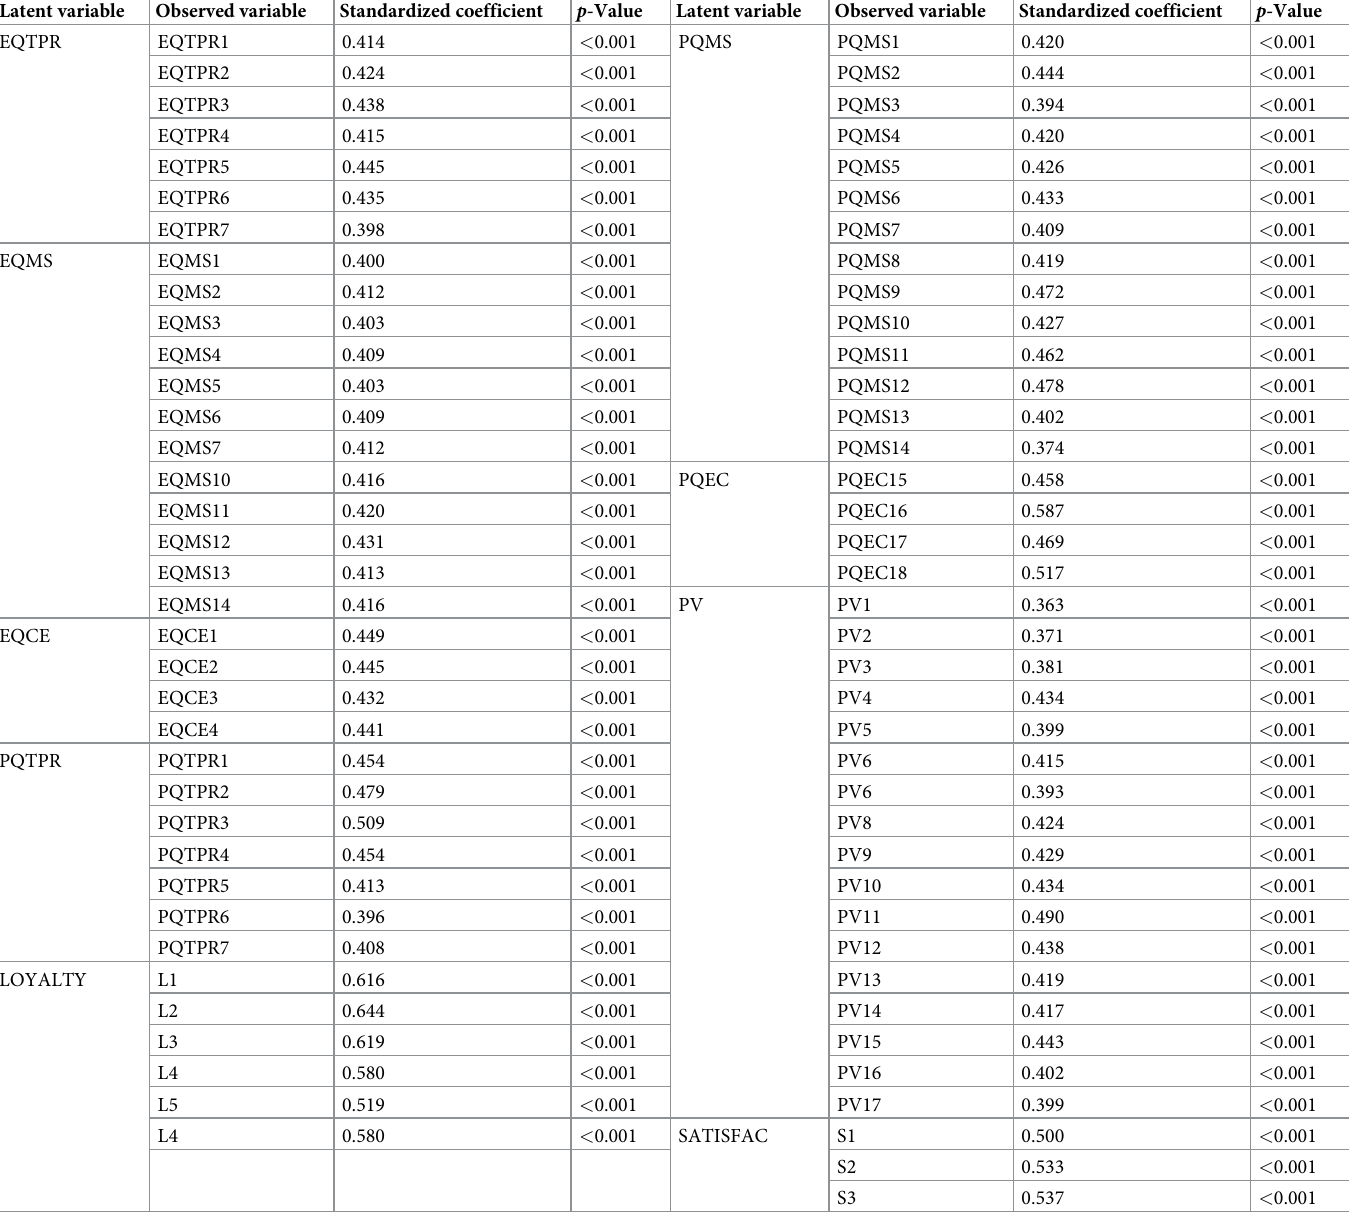
Table 3. Structural coefficients of the items and limit